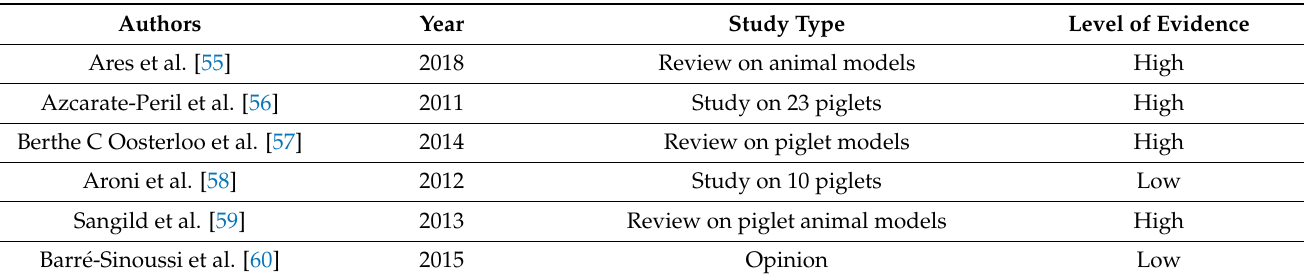
Table A5. Investigation of pathogenetic mechanisms of NEC and other common GIT diseases of neonates associated with microbiota and the use of different research